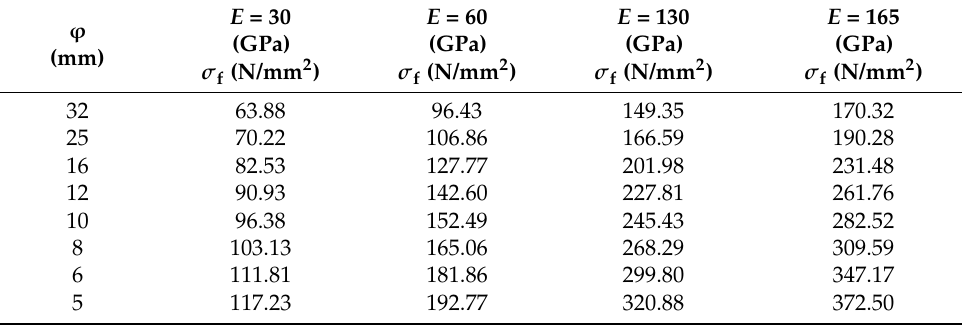
Table 2. Stresses in FRP bars for maximum allowable bar diameter and k 1 =